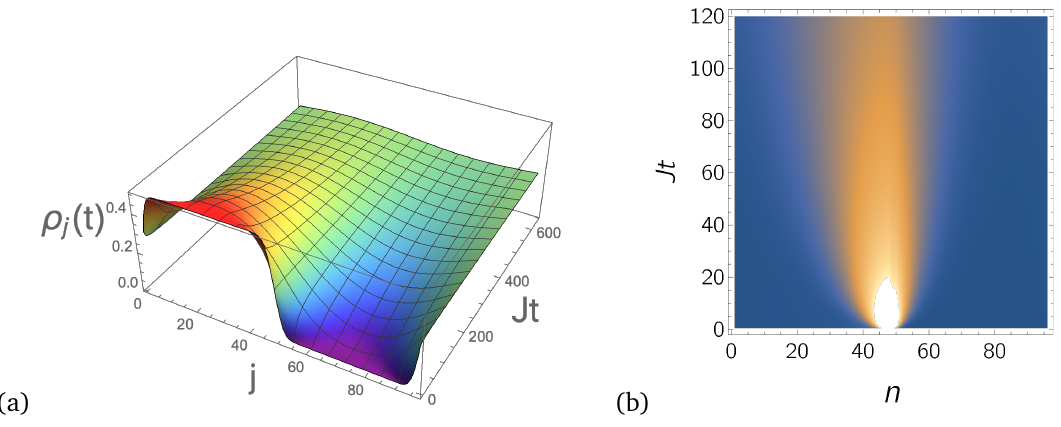
( t ) for the correlated domain-wall initial state (104) as Figure 6: (a) Density ρ j a function of j and time on a ring of L = 96 sites. (b) Connected correlator ( L + 1, n , t ) for the same g − , c 2